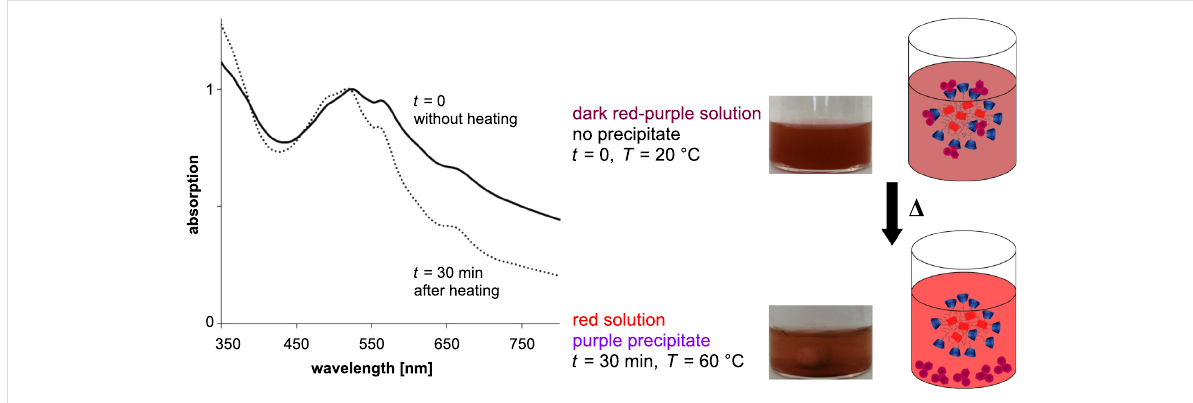
Figure 3: UV–vis spectra of complex 6 in solution (pH 6) before heating (solid line) and after 30 min heating at 60 °C (dotted line), and corresponding photos and schematic illustrations of the solution.